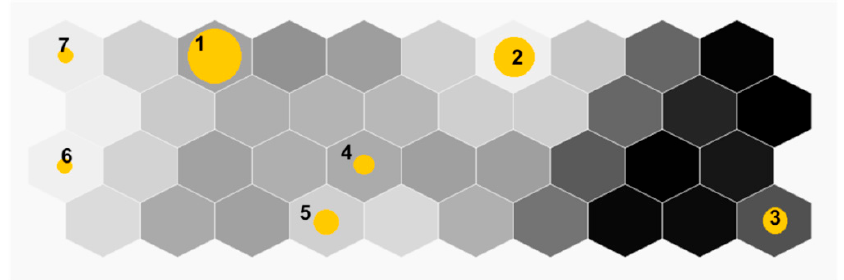
Figure 9. The Employees SOM for the Engineers department.